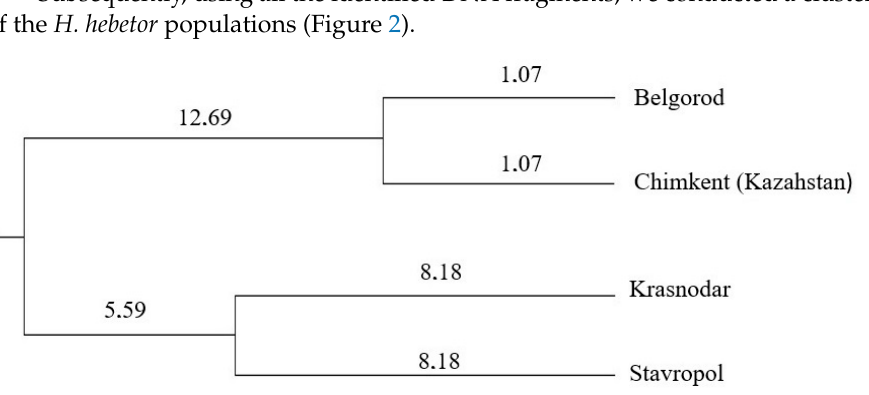
Figure 2. Dendrogram of Cluster Analysis of H. hebetor Geographic Populations. The genetic diversity (the Nei’s index) within the geographical samples from Bel- gorod and Chimkent (Hs = 0.109) is 92% of the total genetic diversity (Ht = 0.119). This indicates a signi fi cant level of gene fl ow between them. The calculated data con fi rm it: the level of genetic fl ow is Nm = 5.74. The relatively low value of the coe ffi cient of genetic di ff erentiation (Gst = 0.08) indicates that 8% of the total genetic variability falls on the share of variability between populations, which determines the di ff erentiation between samples. For the Krasnodar and Stavropol samples, the internal genetic variability is Hs = 0.186 of the total genetic variability Ht = 0.248. The level of genetic fl ow between popula- tions is Nm = 1.51; and the coe ffi cient of genetic di ff erentiation Gst = 0.25. This indicates that the share of intrapopulation variability accounts for 75%, while the share of inter- population variability is 25%. 3.3. Sensitivity of Entomophagous Species to Biological and Chemical Insecticides Traditional insecticides negatively a ff ect the number and e ffi ciency of natural and introduced populations of entomophagous species. Therefore, we studied in the labora- tory the sensitivity of entomophagous species to insecticides used in apple orchards (Ta- ble 5). Table 5. Susceptibility of H. hebetor to biological and chemical insecticides in a laboratory test, (M ± SD). Preparation, Active Sub- stance